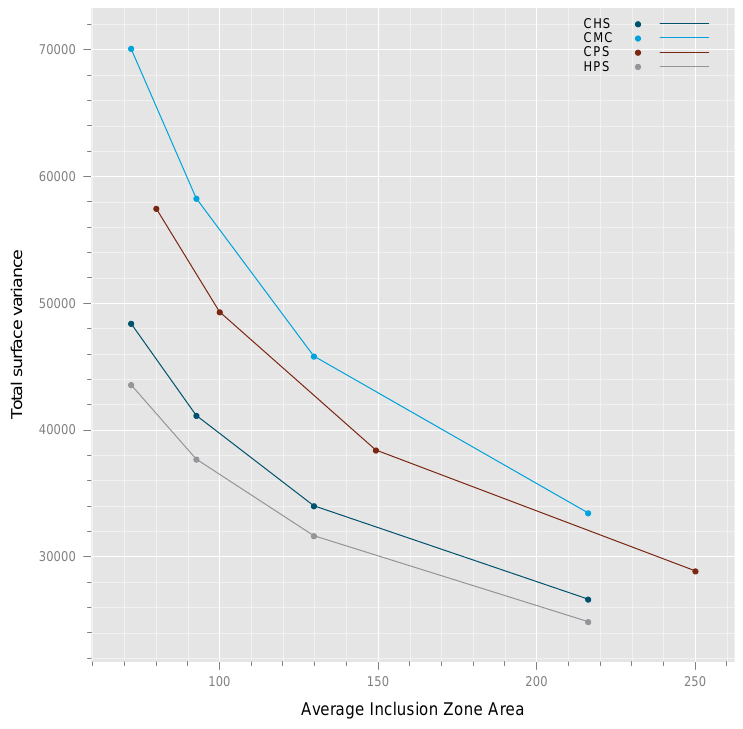
Figure 2. Smith plot of the simulations in Table